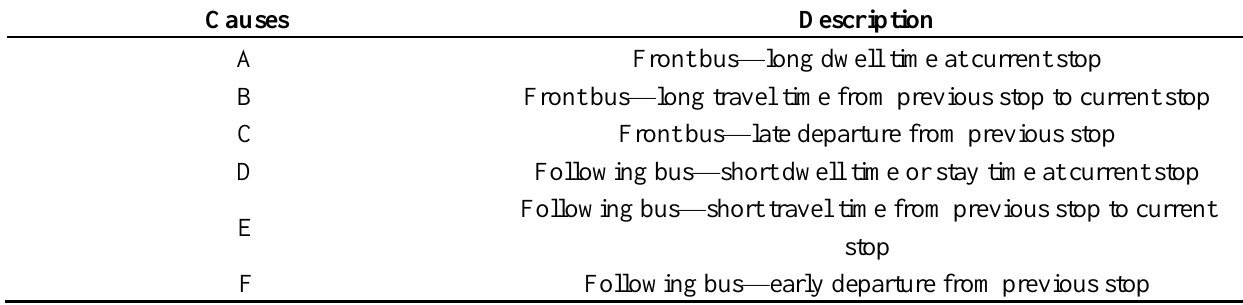
Table 5. Relative degree of importance for pairwise